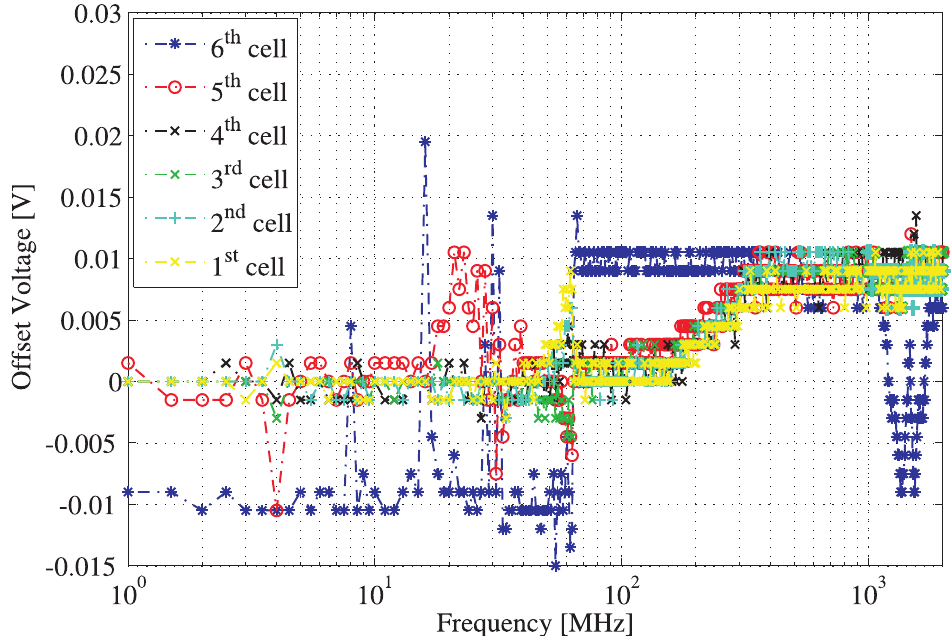
Figure 6. EMI-induced offset in the cell voltage readings obtained in accordance with DPI failure levels of Figure 4 (DM injection performed on the 6th cell positive terminal, without RC filters).